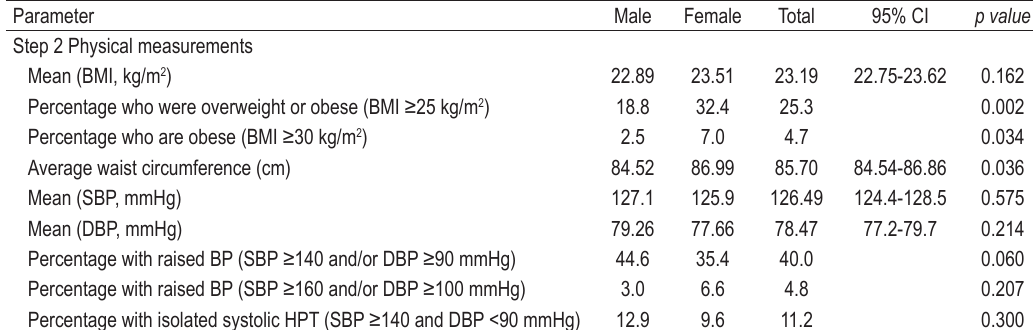
TABLE 3. Summary of results from step 2 WHO STEPS approach studying risk factors of NCDs (%)